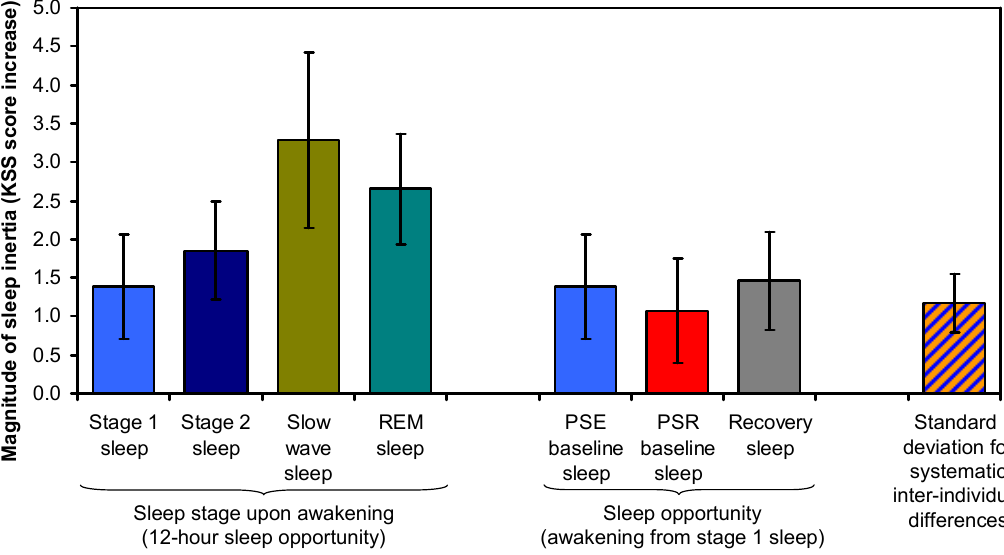
Figure 5. Magnitude of SI, estimated as the level of sleepiness immediately after awakening relative to the baseline level of sleepiness to which SI decays over time awake. The four bars on the left show the effect of SI on sleepiness (mean ± SE) after awakening from each of the different sleep stages in the 12-h sleep opportunities during the study (see Figure 1). The three bars in the middle compare the effect of SI on sleepiness (mean ± SE)—assuming awakening from stage 1 sleep—between the 12-h baseline sleep opportunity in the PSE condition (bar repeated from the left), the 6-h baseline sleep opportunity in the PSR condition, and the 12-h recovery sleep opportunity after 36 h of total sleep deprivation in either condition. For comparison, the bar on the right shows the standard deviation for systematic interindividual differences that persisted regardless of condition or sleep stage at awakening.